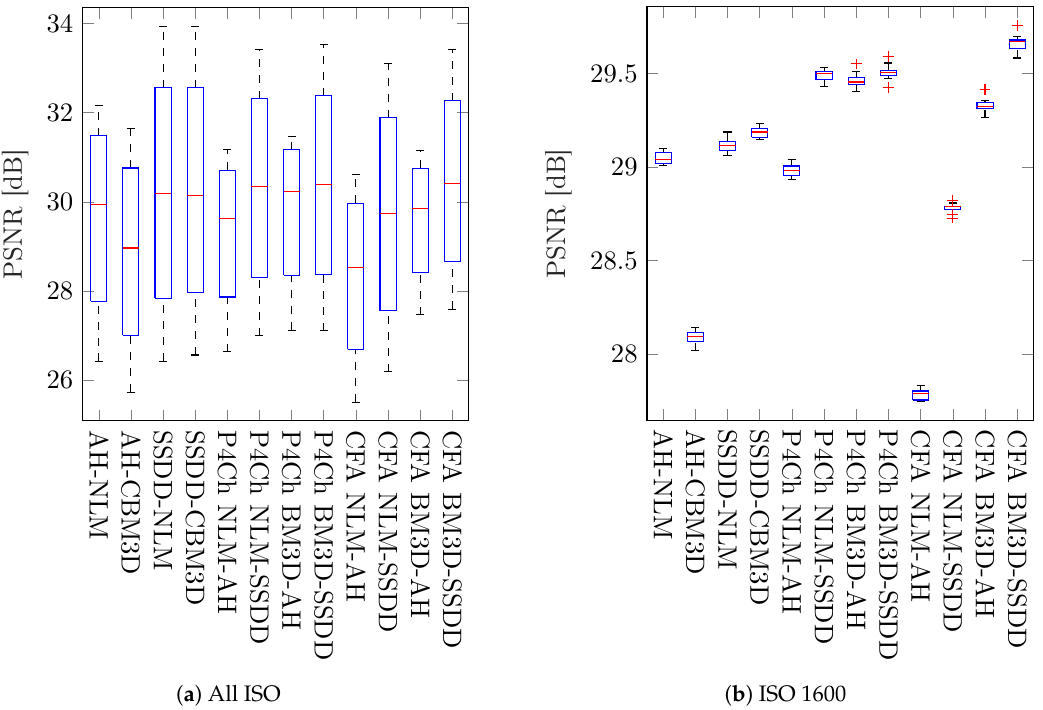
Figure 15. Box plots of PSNR coefficient for the bird test